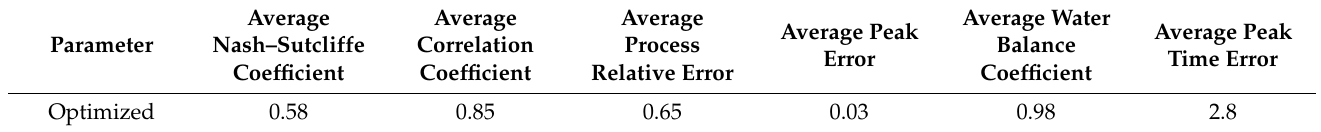
Table 4. Statistical indicators of the flood simulation results after parameter